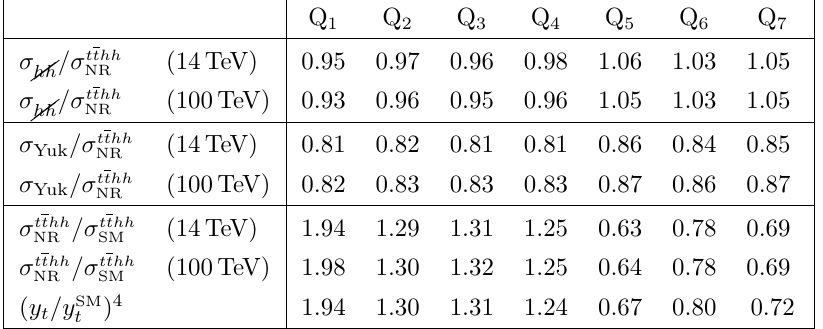
and σ are Yuk hh is the total NR- tthh . NR means we disregarded the SM trilinear Yuk in the MCHM and SM t